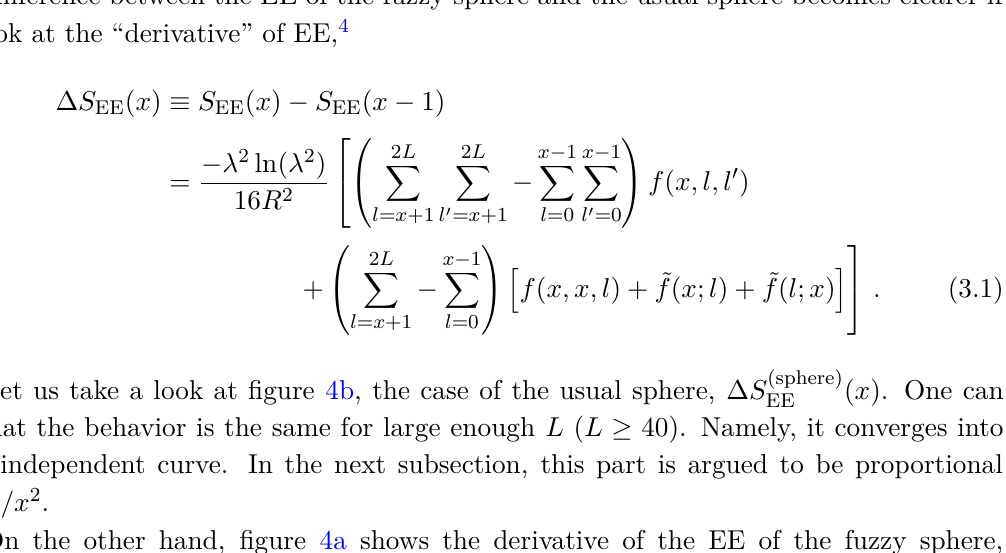
Figure 3 . The EE of the fuzzy sphere without the non-planar phase factor, S (NNP) − λ 2 ln λ 2 / 16 R 2 factor). The horizontal axis is x . R is set to be